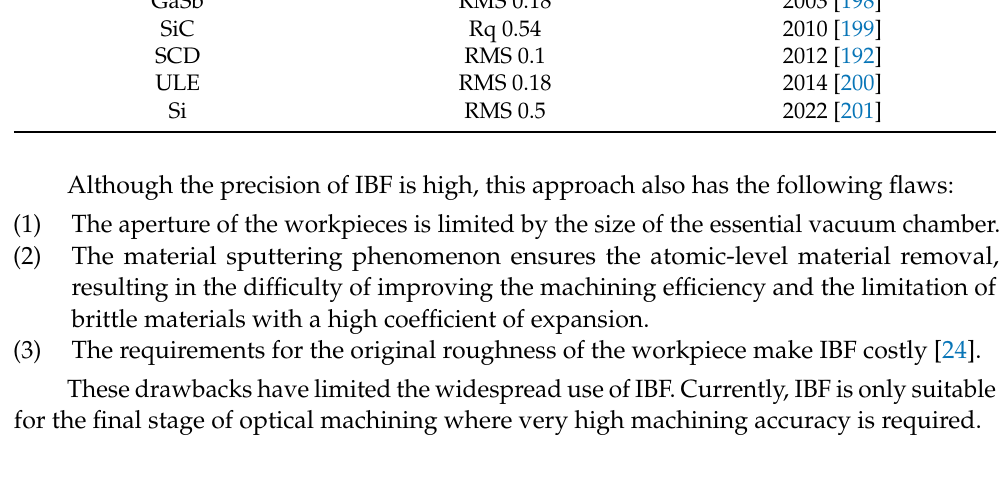
Figure 28. The AFM images of unprocessed and IBF-processed SCD. Reproduced with permission from [192]: ( a ) The first sample; ( b ) The second sample.